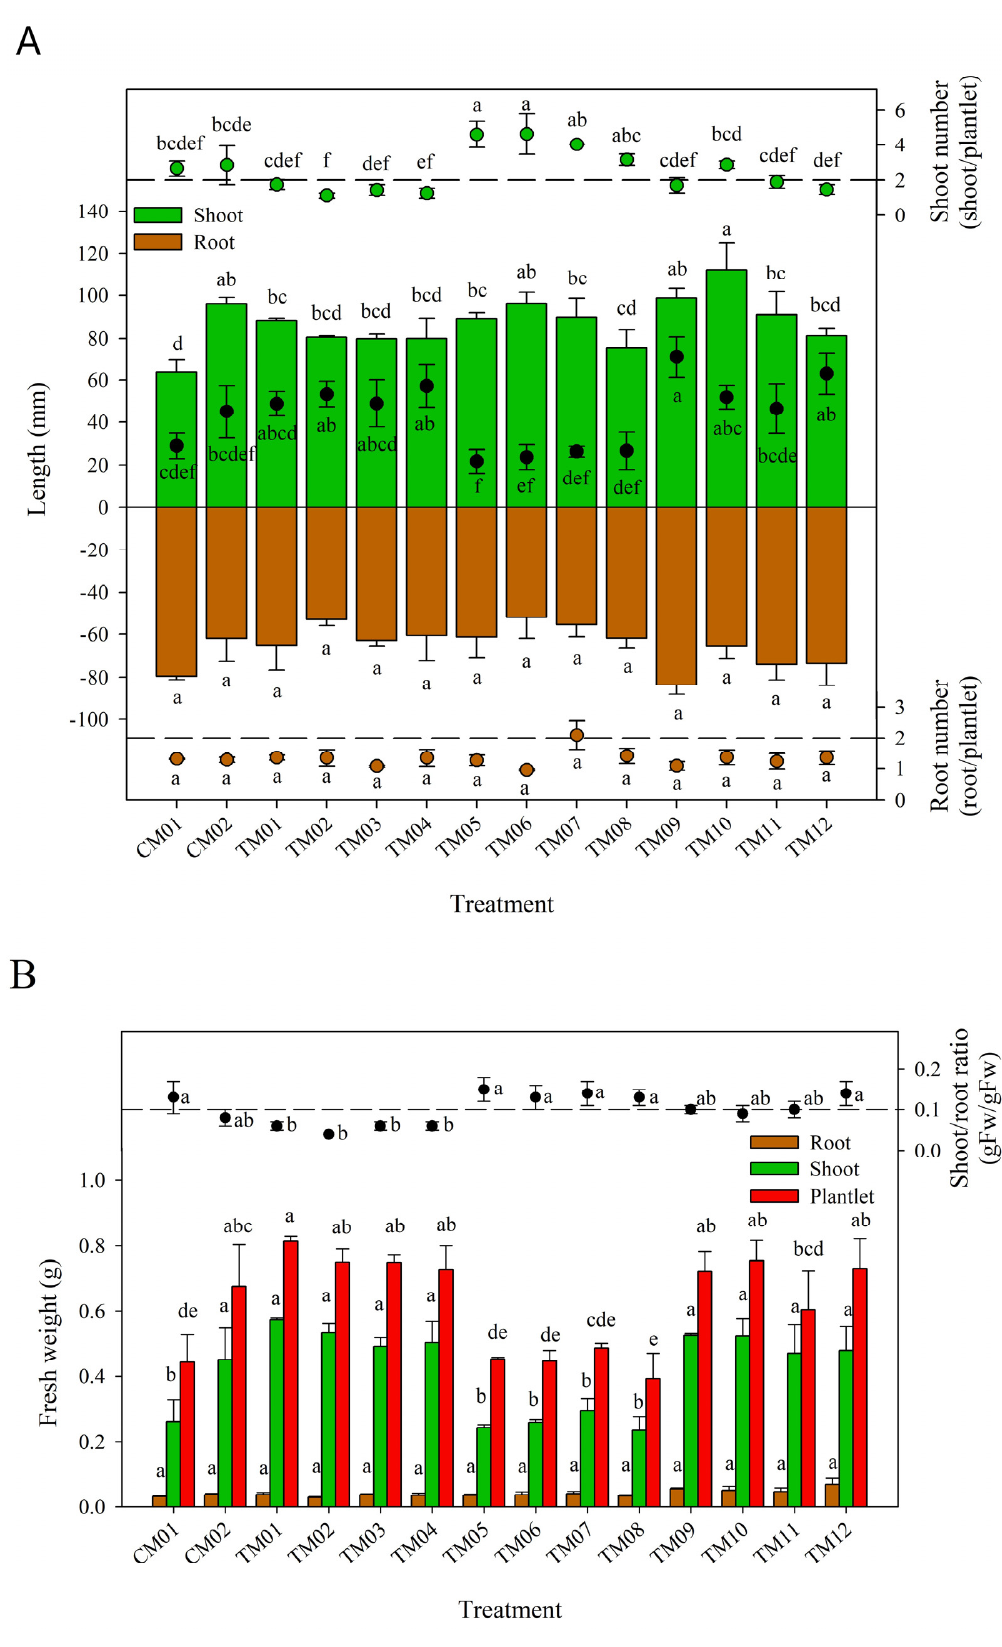
Figure 5. Shoot regeneration number, root induction number, and shoot and root lengths ( A ); fresh weight of plantlets, shoots, and roots, as well as root/shoot ratio ( B ) of Hylocereus polyrhizus ‘Da